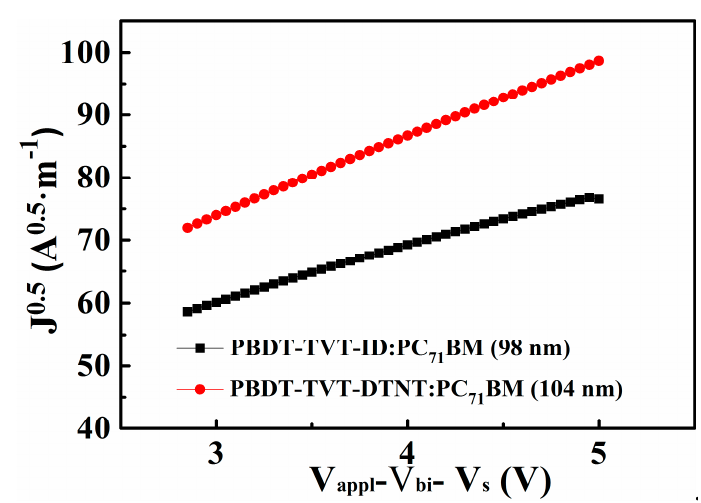
Figure 4. J - V characteristics of hole-only devices.